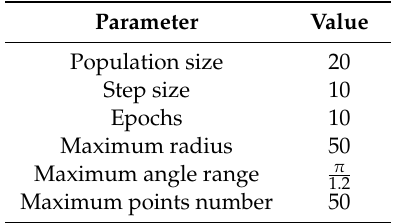
Table 1. The parameters of the GA-based methods.